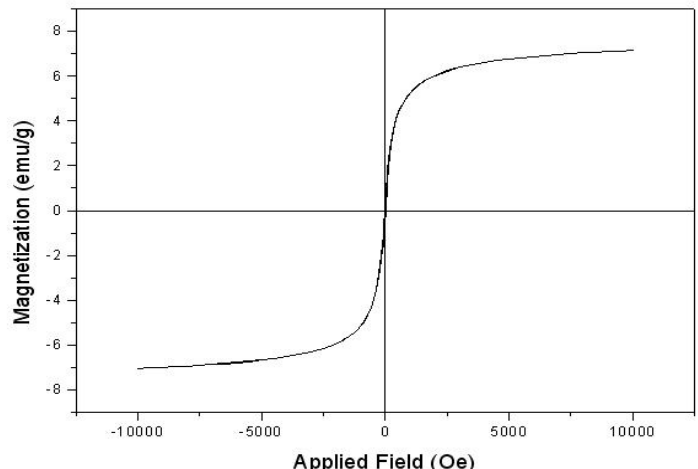
O nanoparticles at room temperature 3 4